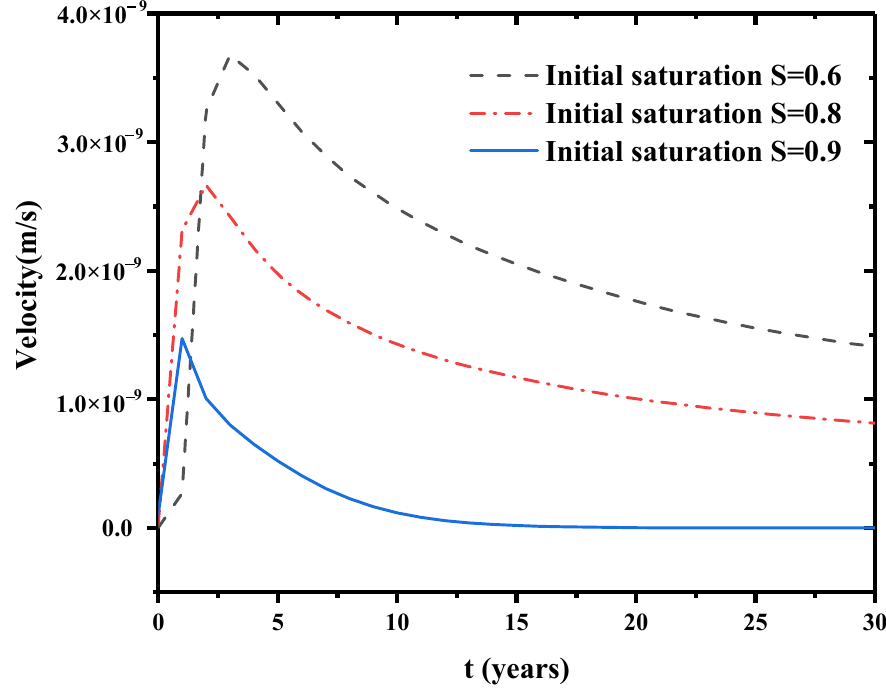
Figure 8. Flow velocity variation at the bottom.